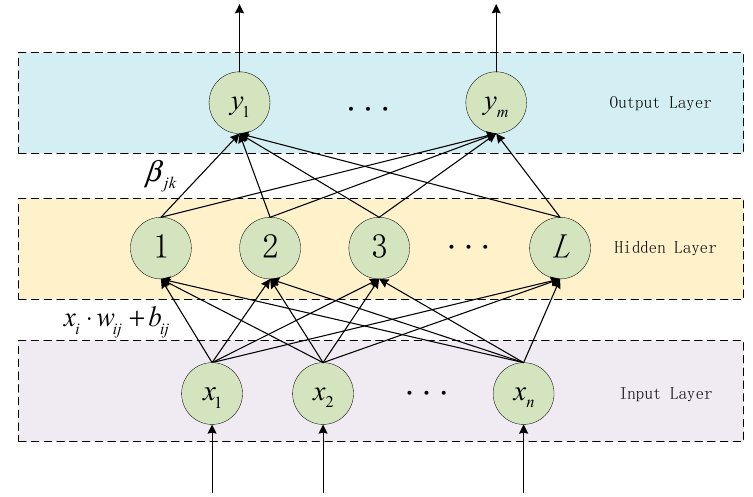
Figure 2. An example of the extreme learning machine (ELM) model.